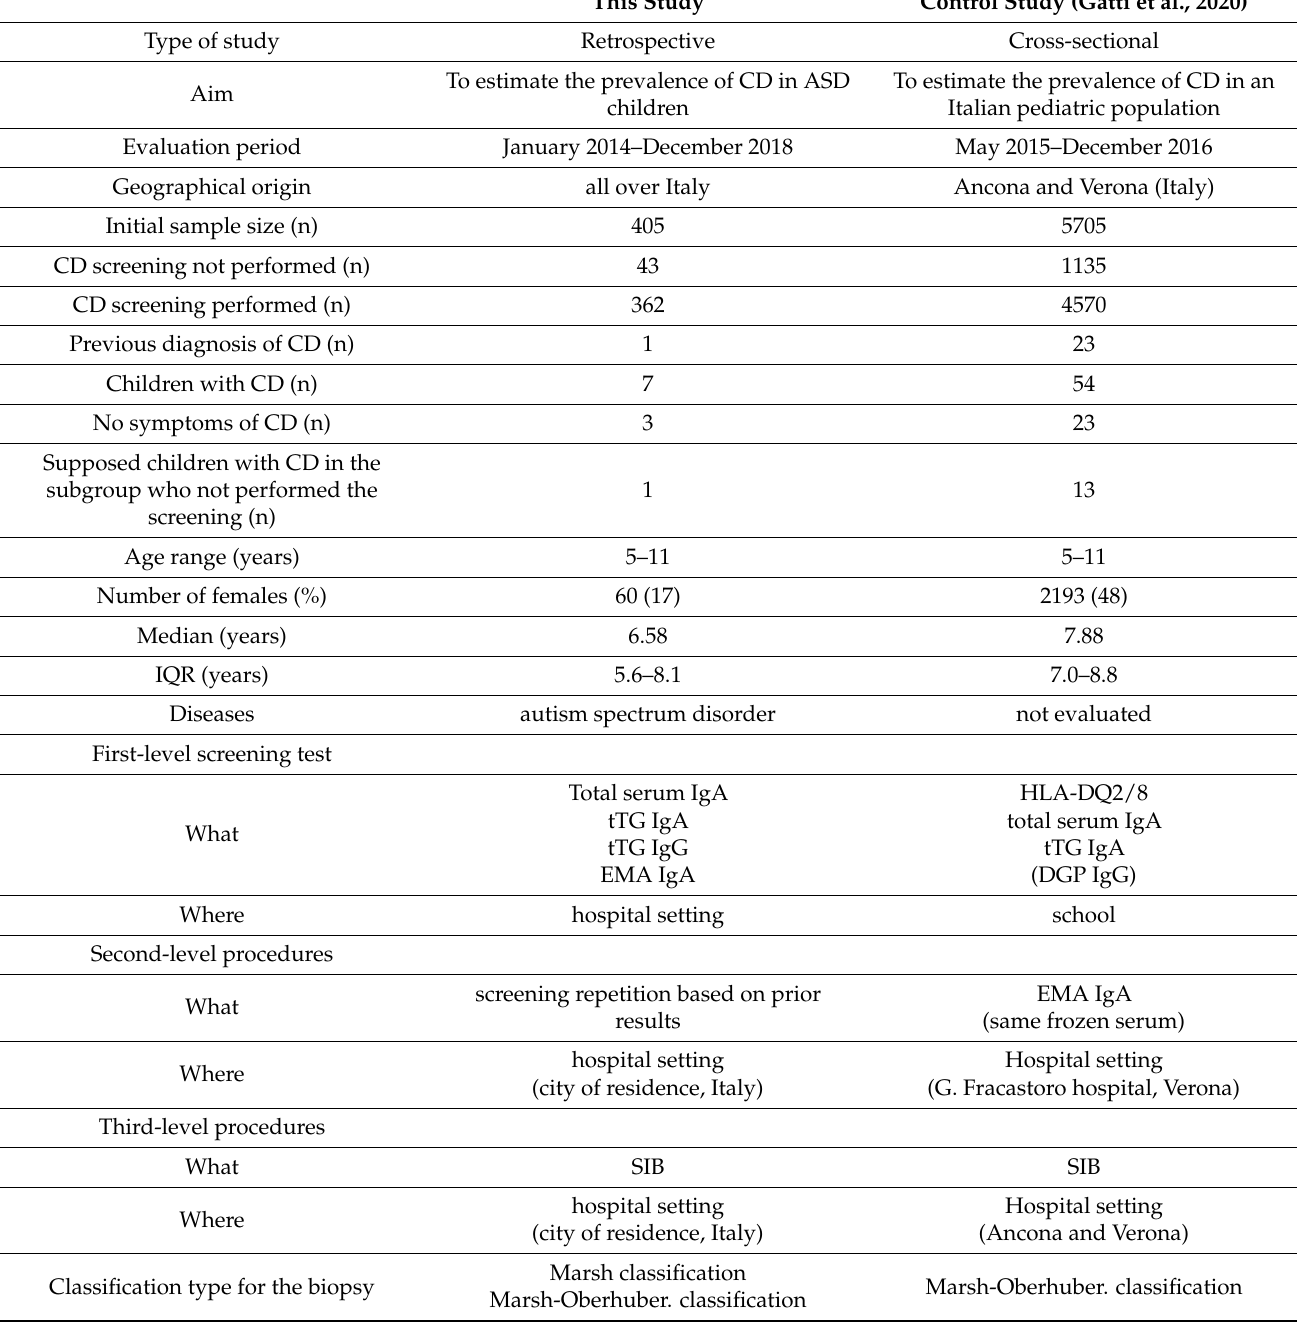
Table 2. Comparison of sample- and CD-evaluation characteristics between our study and the study considered as control (Gatti et al.,